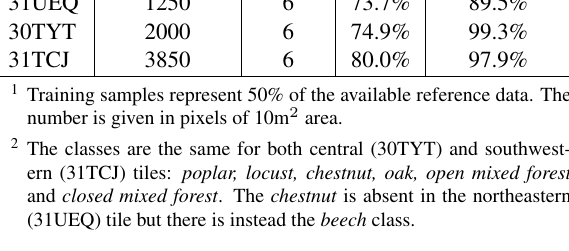
Table 3. Local classification results for each Sentinel-2 tile